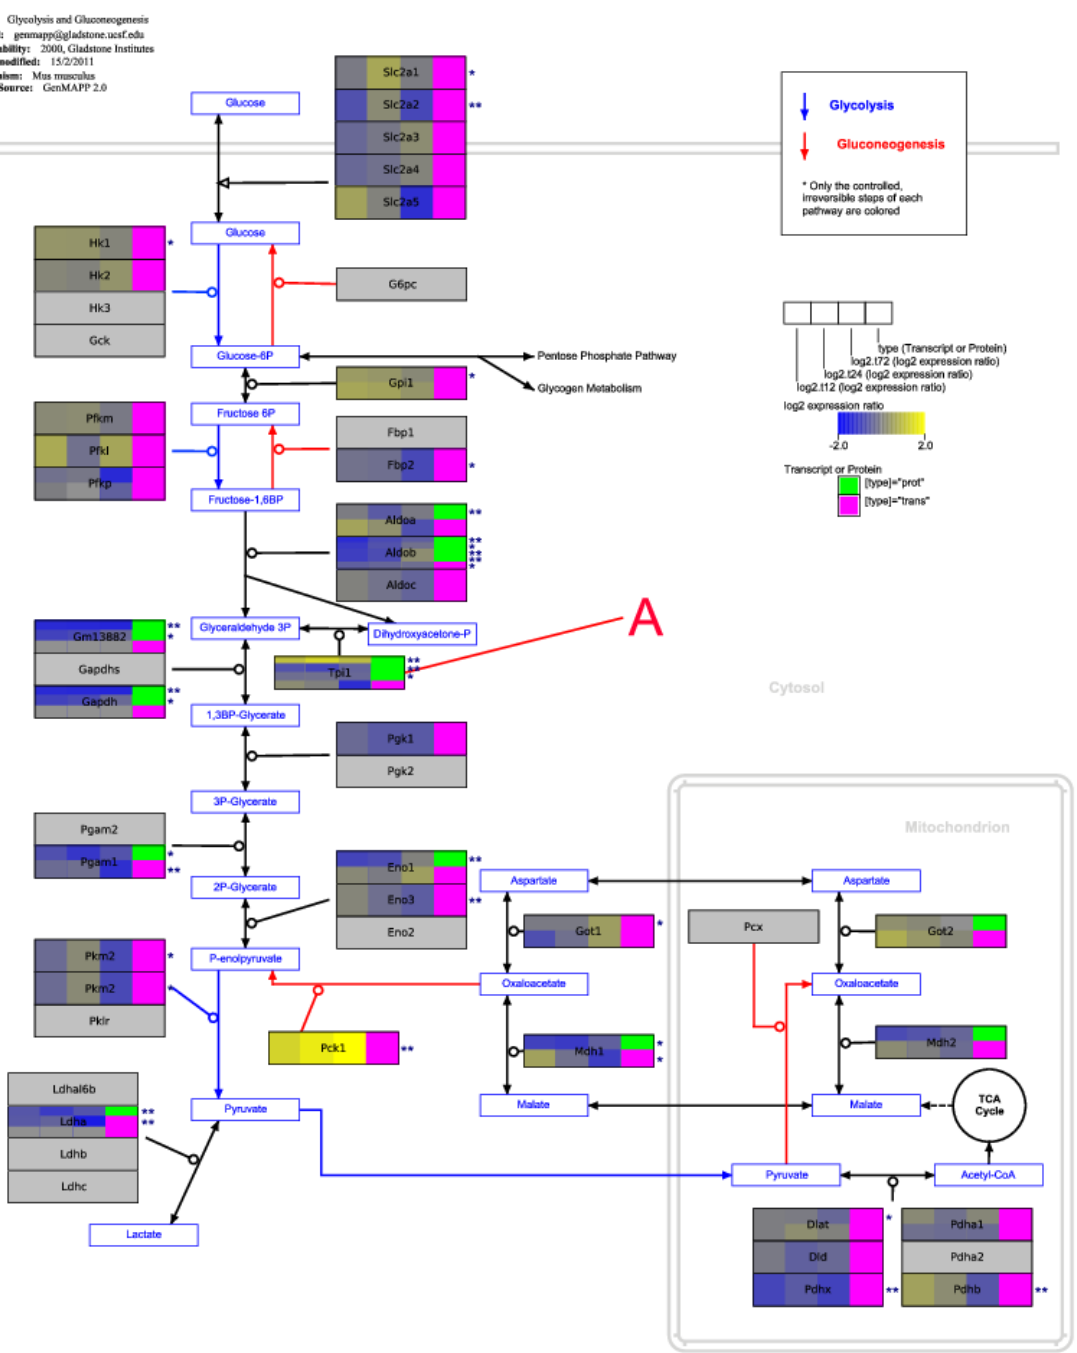
Figure 2: Glycolysis and Gluconeogenesis. Visualization of expression data on the glycolysis / gluconeogenesis pathway. Each colored box represents a gene product. Blue indicates decreased expression levels, yellow increased. Each box is a heat map with rows representing probes or spots, and columns representing time points. The rightmost column is a flag that indicates if the given row is a protein spot (green) or microarray probe (pink). The asterisks denote significance. Multiple probes and/or spots can be shown in a box. Tpi1 is marked with the letter A. More pathway diagrams can be found in supplemental file 2